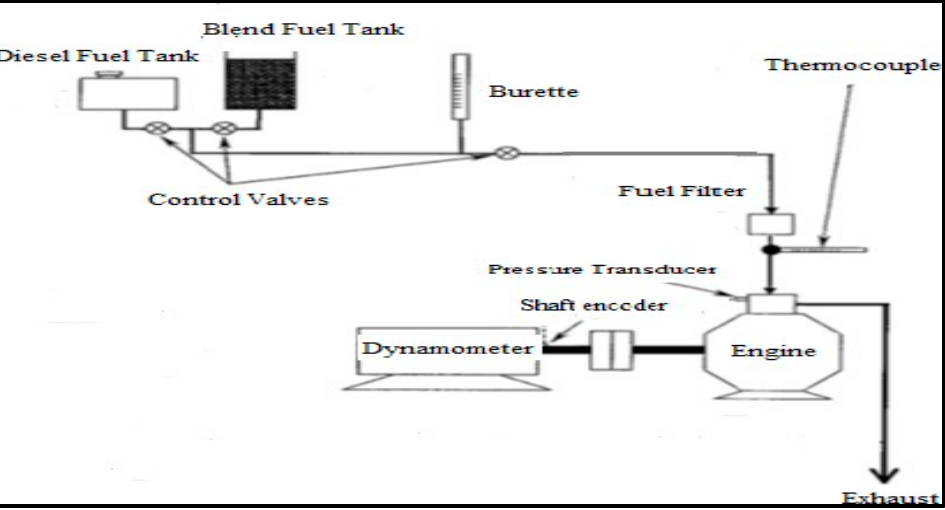
Figure 2. Graphical illustration of experimental setup. Table 3. Engine specifications.